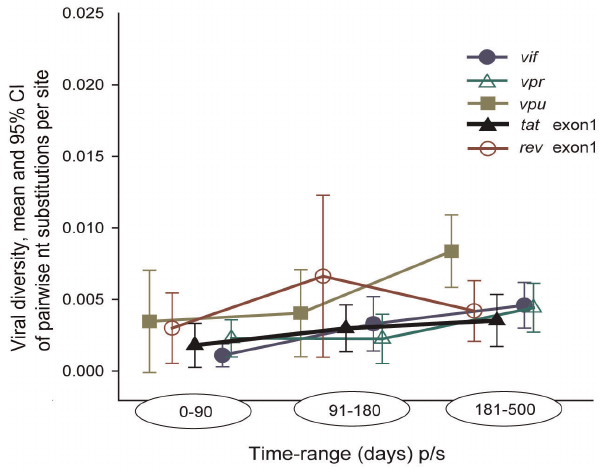
Figure 4. HIV-1C diversity, mean and 95% confidence intervals for non-structural genes vif , vpr , vpu , tat exon 1 and rev exon 1 over the first 500 days p/s. Viral diversity for each subject was calculated using maximum composite likelihood model [56].